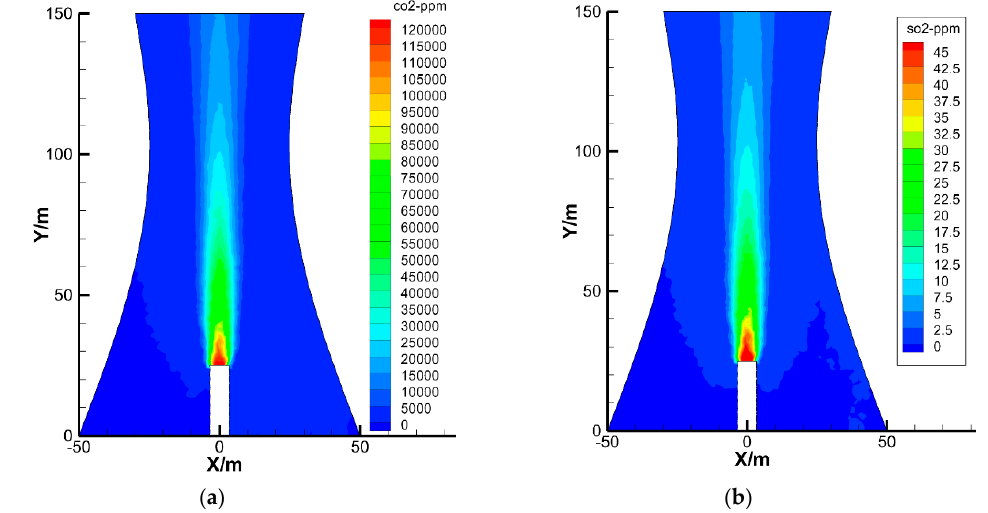
Figure 9. Concentration nephograms of CO 2 and SO 2 in the cooling tower. ( a ) CO 2 ; ( b ) SO 2 . Three horizontal positions in the tower middle (70 m), tower throat (110 m), and tower outlet